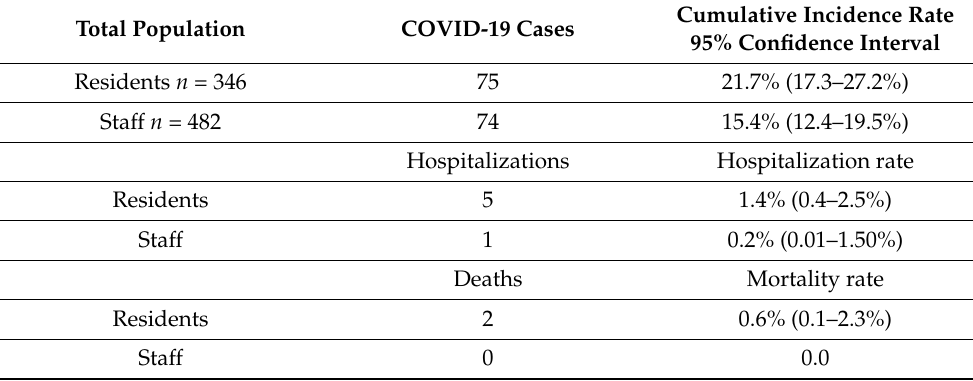
Table 2. Incidence, hospitalization, and mortality COVID-19 in long-term care residential homes for patients with chronic mental illness (I). Health Departments 2 and 3 of Castellon. March